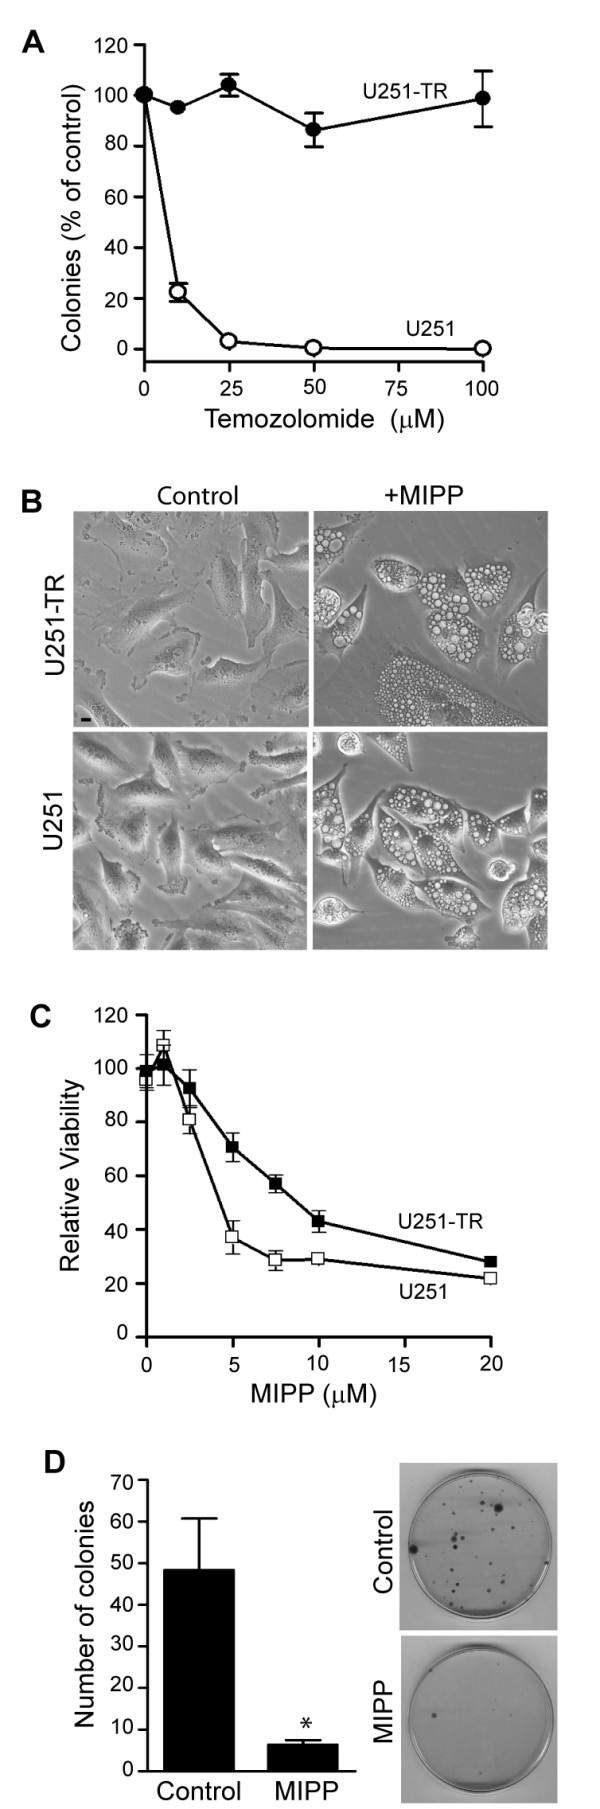
MIPP has similar effects on cell morphology and viability in temozolomide-resistant (U251-TR) and parental (U251) glioblastoma cells. A) Cells were treated with the indicated concentrations of TMZ for 48 h. Colonies were counted as described in Materials and Methods and the results were expressed as the percentage of the mean value for parallel control plates for the same cell lines without drug. Each point is the mean from three plates (± SD). B) Phase-contrast images were obtained after treatment of cells for 48 h with 10 μM MIPP or an equivalent volume of DMSO (control). C) MTT assays were performed after treatment for 48 h with the indicated concentrations of MIPP or an equivalent volume of DMSO. The quadruplicate MTT values for the MIPP-treated wells were expressed as percent of the mean for the parallel DMSO-treated wells. Relative IC50 values were calculated from nonlinear regression analysis of sigmoidal dose response curves plotted with GraphPad Prizm 4.0 (La Jolla, CA). D) U251-TR cells were treated with 10 μM MIPP or an equivalent volume of DMSO (control) for 2 days and colony forming assays were performed. The results shown are the mean (± SD) of triplicate dishes, with representative dishes shown at the right. The decrease in the number of colonies for the MIPP-treated cells (*) was significant at p < 0.001.